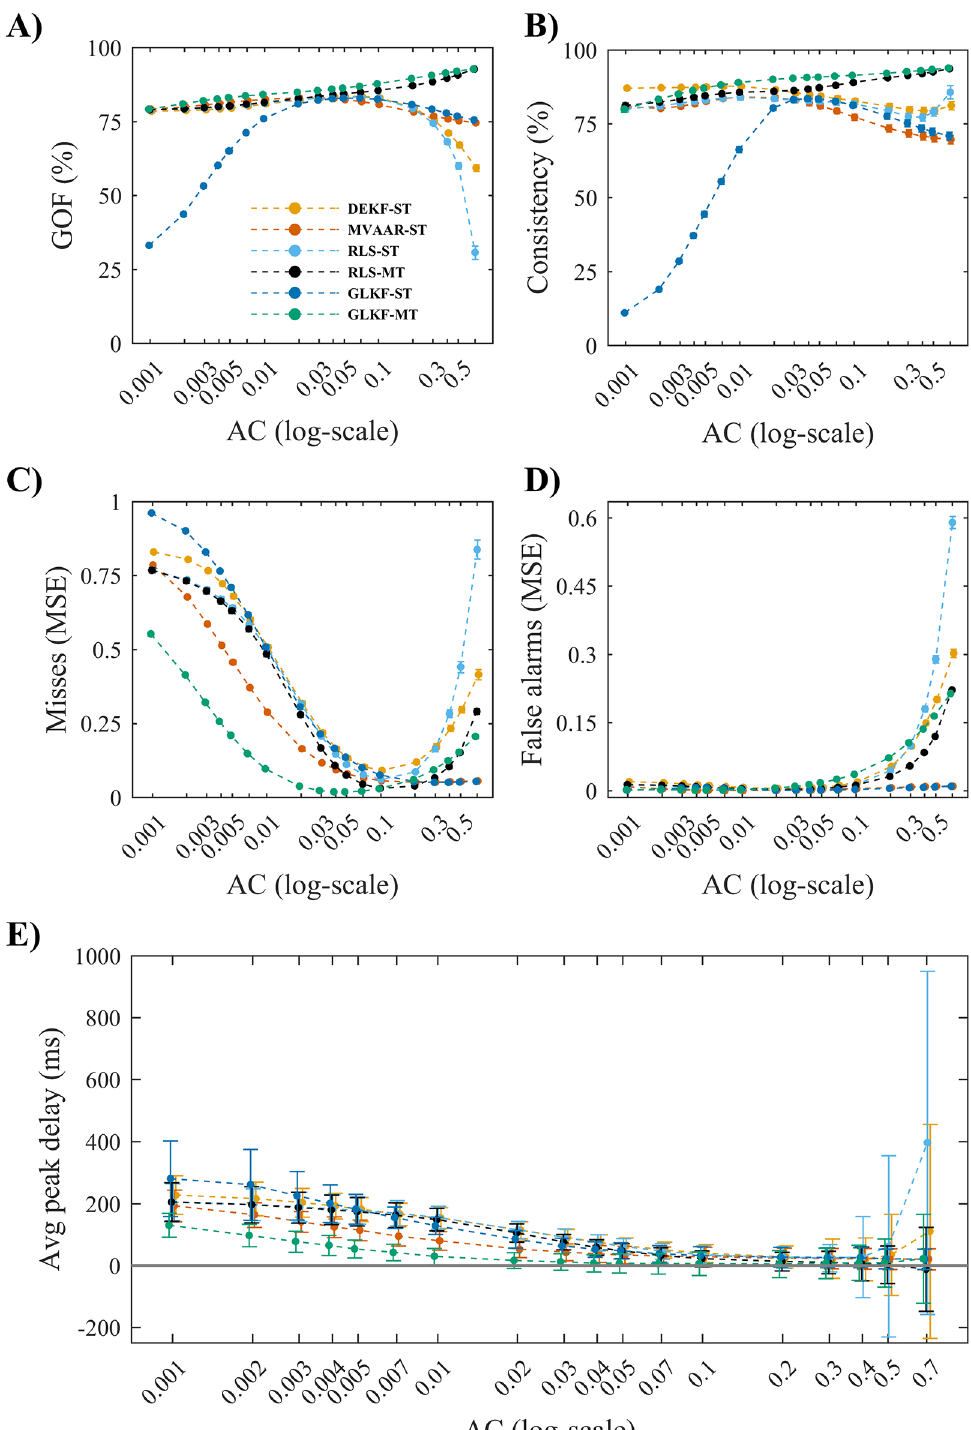
Fig 3. Simulation 1 on the effects of varying adaptation coefficients. A) Shows the goodness-of-fit (GOF). B) Shows the percent consistency. C) Shows the misses (normalized MSE), which are computed on the edges with simulated connections (Fig 1A). D) Shows the false alarms (normalized MSE), computed on the edges with null connections. E) Shows the average peak delay across the four imposed connections in the 5-nodes model (Fig 1B). The results in each plot are shown as a function of adaptation coefficients AC, using logarithmic scale for the x-axis, for the four recursive